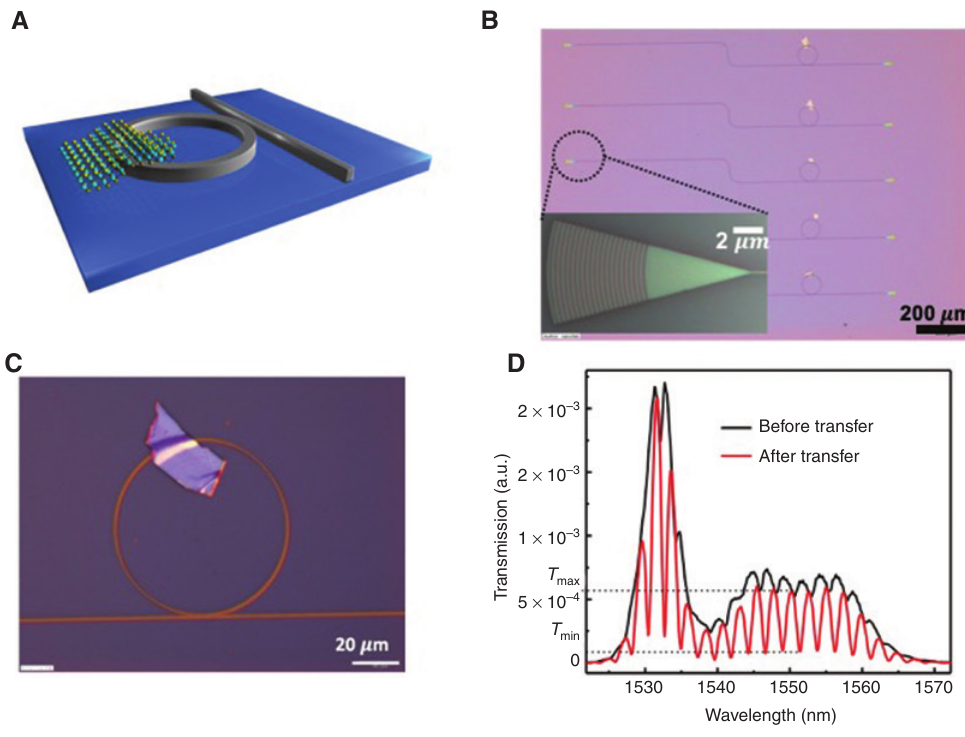
Figure 1: TMD-loaded MRR. (A) Schematic representation and (B) optical microscopy image of a taped-out Si photonic chip with grating coupler. Optical micrograph of a grating coupler designed for TM mode at 1550 nm in the field of a view of 100 × objective (inset). (C) Zoomed image of an MRR ( R = 40 μ m and W = 500 nm) covered by an MoTe flake of length ( l ) precisely transferred using our developed 2D printer technique. (D) Transmission output 2 before and after the transfer of MoTe showing an improvement of coupling efficiency as it brings the device close to the critical coupled 2 regime after the transfer of the TMD